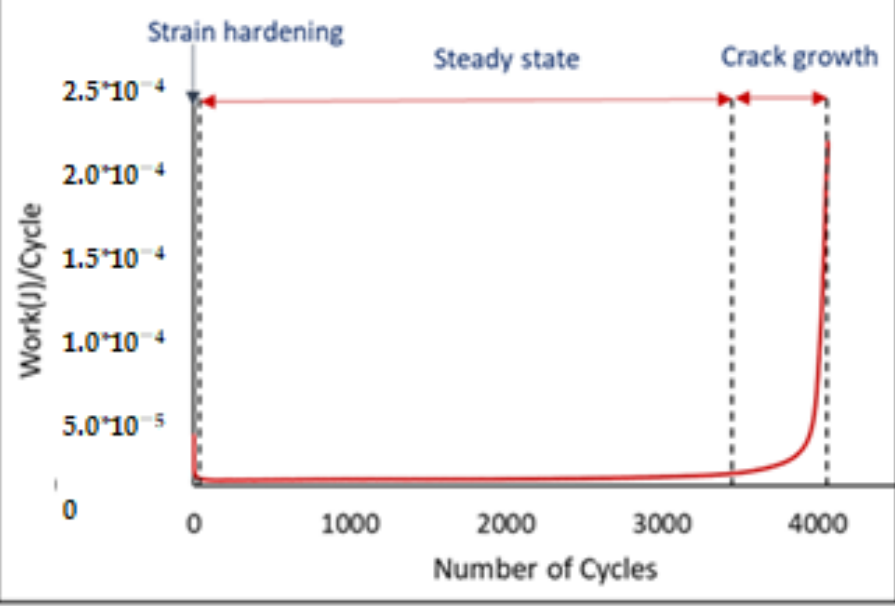
Figure 7. Steady state region for SAC305 solder joints at 25 °C operating temperature and cycled at 16 MPa stress level. Table 3. Average inelastic work per cycle and plastic strain values.